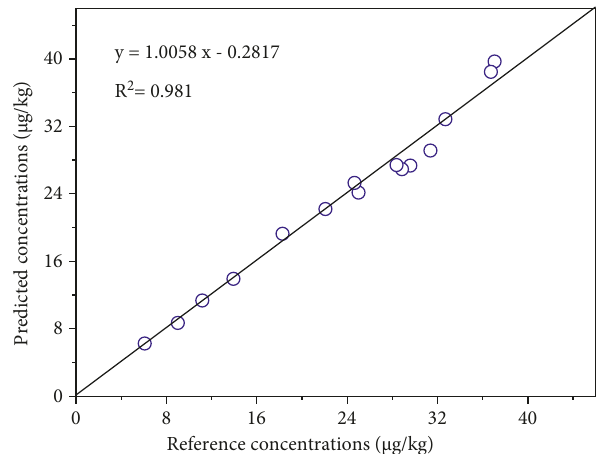
Figure 11: Correlation between reference and predicted concen- trations of AFB 1